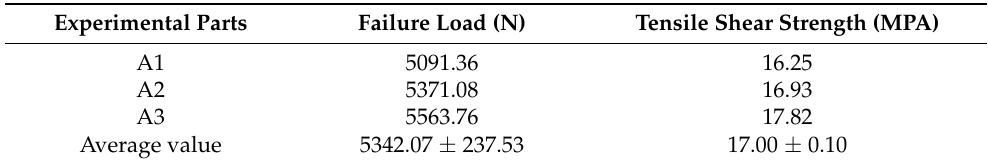
Table 3. Experimental results of tensile shear test.